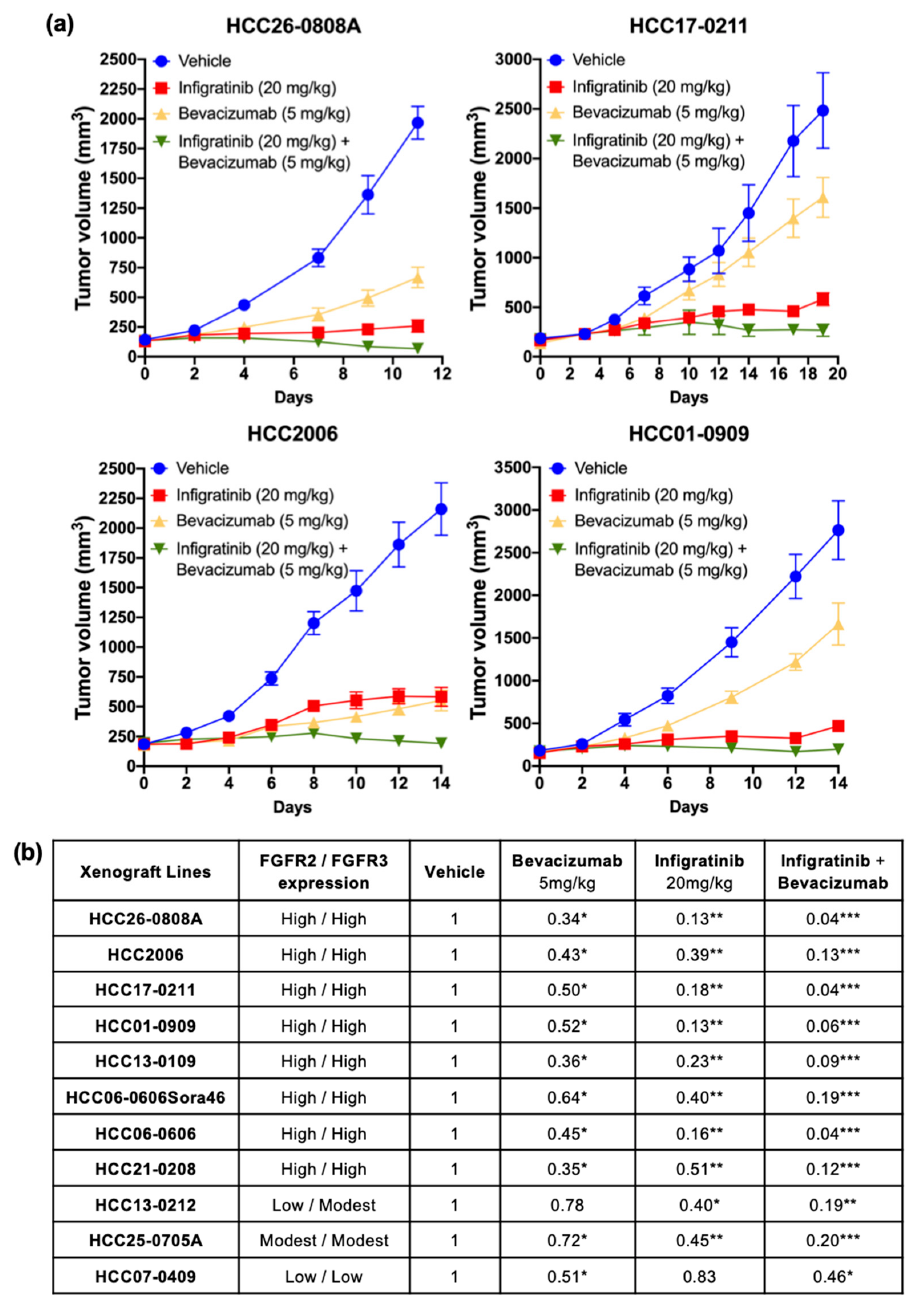
Figure 1. Infigratinib/Bevacizumab demonstrates potent antitumor activity in hepatocellular carcinoma (HCC) models. Tumors were implanted subcutaneously into severe combined immunodeficient (SCID) mice as described [23]. Mice ( n = 10 per group) were subsequently treated as follows: (1) IP injection with 200 μ L saline (vehicle/control), (2) 20 mg/kg Infigratinib administered orally, (3) IP injection with 5 mg/kg Bevacizumab, and (4) combined Infigratinib and Bevacizumab for indicated days. Tumor volumes were calculated and the mean tumor volumes ± SEs for 4 representative models are shown ( a ). The efficacy of Infigratinib/Bevacizumab combination was determined using the T/C ratio, where T and C are the median weights of drug- and vehicle-treated tumors at the end of treatment, respectively. The T/C ratios are shown ( b ). * p < 0.05; ** p ≤ 0.01; *** p ≤ 0.001 (One-way ANOVA with post hoc Tukey analysis).